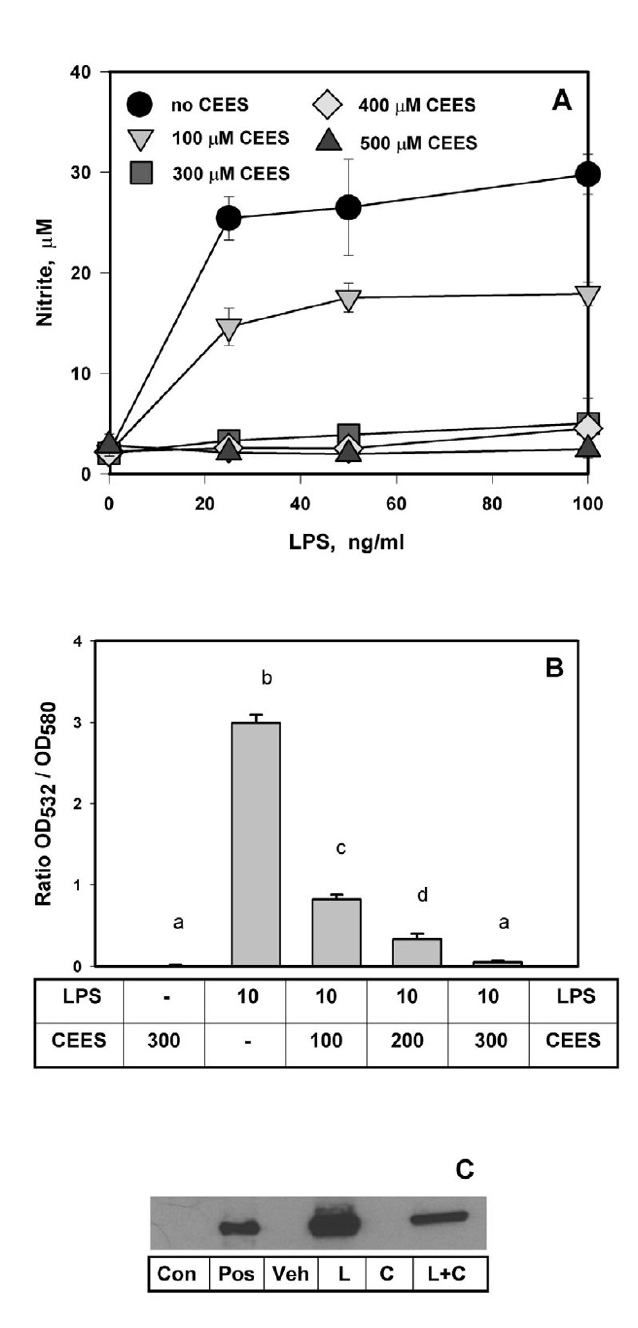
Figure 1 CEES inhibits NO production and iNOS expression in LPS stimulated RAW264.7 macrophages . Panel A : Macro- phages were simultaneously treated with various levels of CEES (as indicated) and low doses of LPS (as indicated). NO produc- tion was monitored as the concentration of nitrite in the culture medium after 24 h. Panel B : Cells were treated similarly as for Panel A ; LPS, 10 ng/ml; CEES, 100, 200, or 300 μ M (as indicated). Means not sharing a common letter are significantly different (p < 0.05). Nitrite levels in the culture medium (OD at 532 nm) were normalized to the amount of viable cells (OD of the MTT product at 580 nm). Panel C : Western blot analysis of iNOS protein from cells simultaneously incubated with 300 μ M CEES and/or 10 ng/ml LPS for 24 h; cell lysates were prepared as described in Materials and Methods: Con, control cells; Pos, iNOS protein for positive control; Veh, vehicle; L, 10 ng/ml LPS stimulated cells; C, 300 μ M CEES treated cells; L+C, LPS/CEES treated